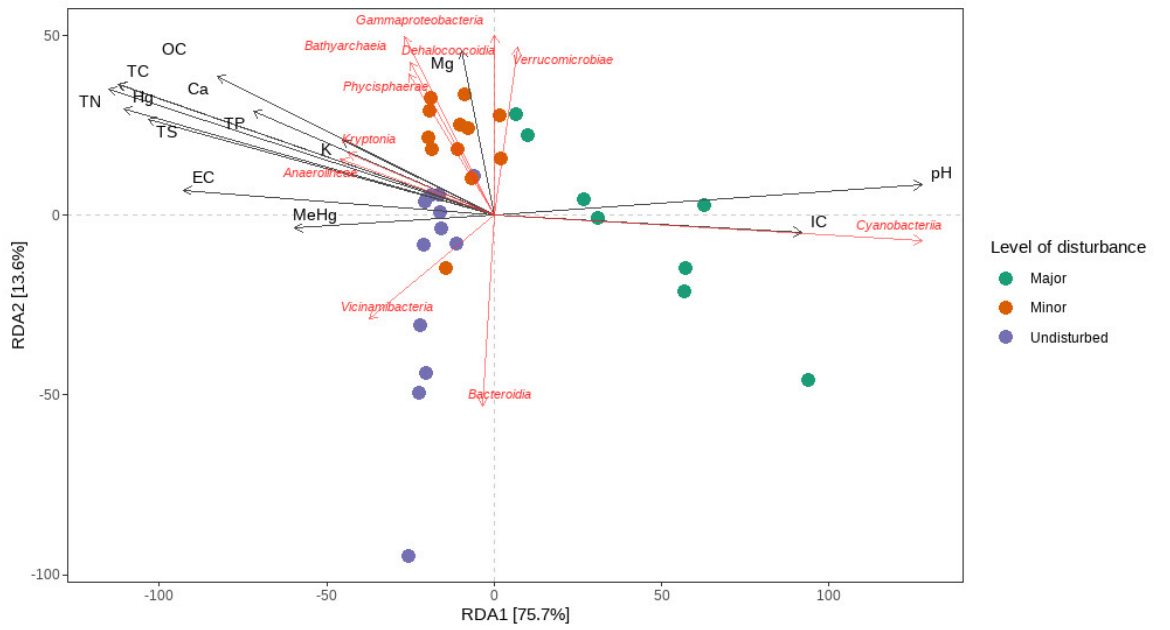
Figure 7. The ordination plot of the distance-based redundancy analysis (RDA). The ordination plot showcases the vectors representing the environmental variables as well as important taxonomical classes.